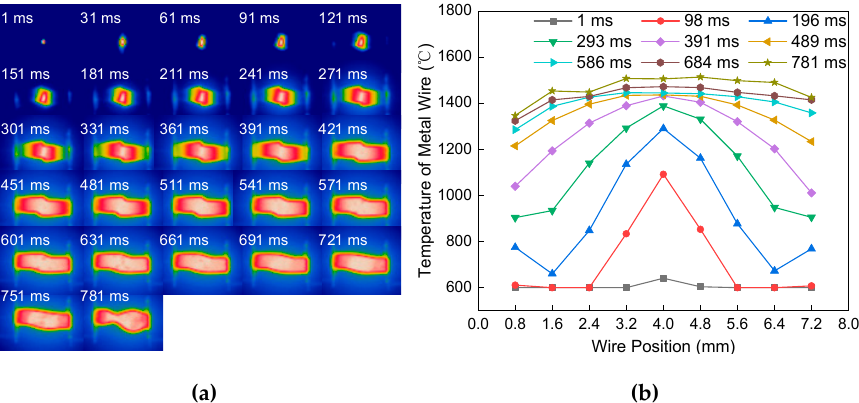
Figure 9. E ff ect of wire length on the melting of double metal wires. ( a ) Melting process and Figure 9. Effect of wire length on the melting of double metal wires. (a) Melting process and (b) ( b ) temperature temperature distribution.